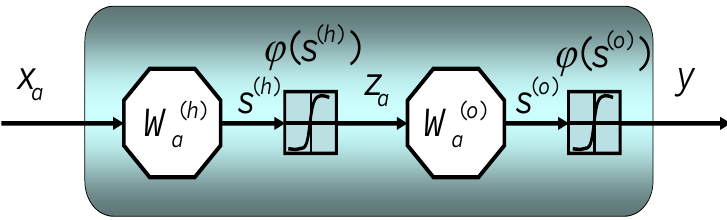
Figure 8. The nonlinear mapping capability of a